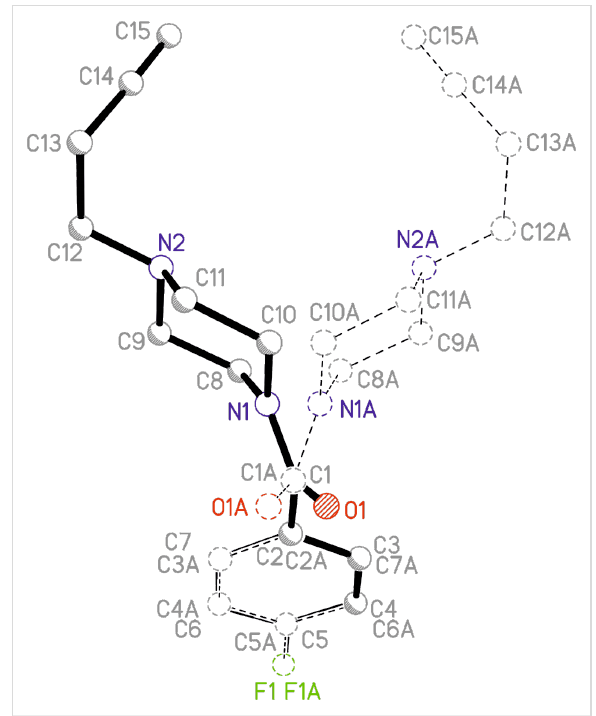
Figure 7: Superimposition fit of the two conformers, which exist in the ratio of 1:1 in the solid state structure of compound 4b (label A marks the atoms of the second